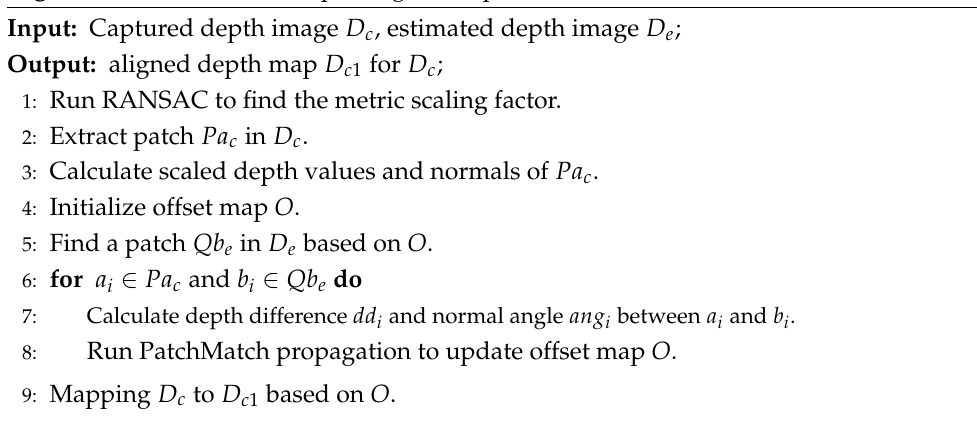
Algorithm 1 Overview of depth alignment